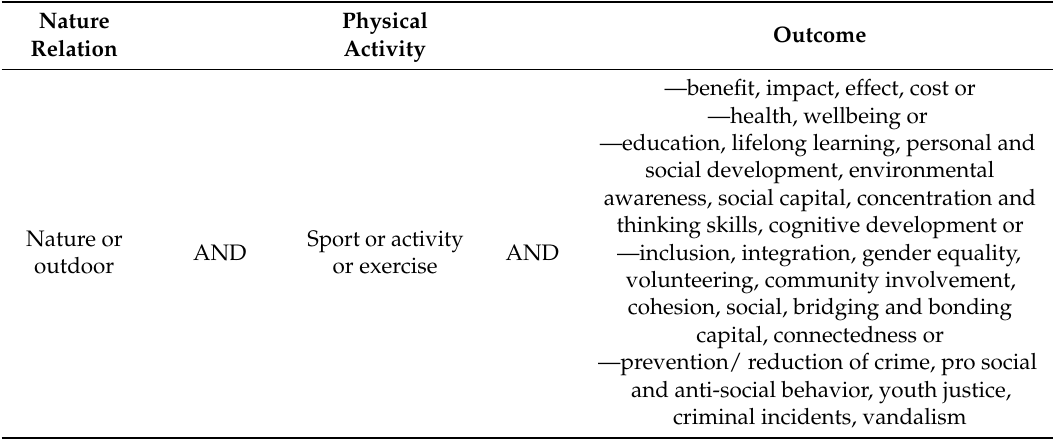
Table 1. Key words for creation of search string formula.